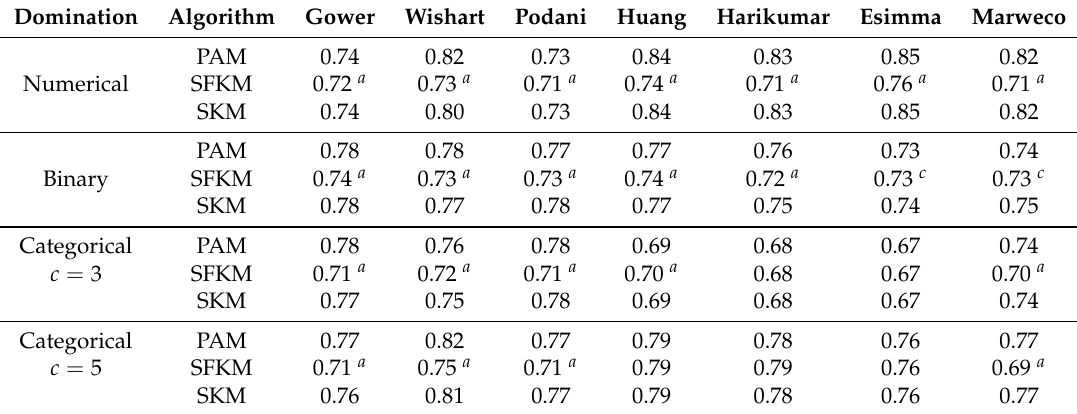
Table 4. Rand indices of the different proportions of